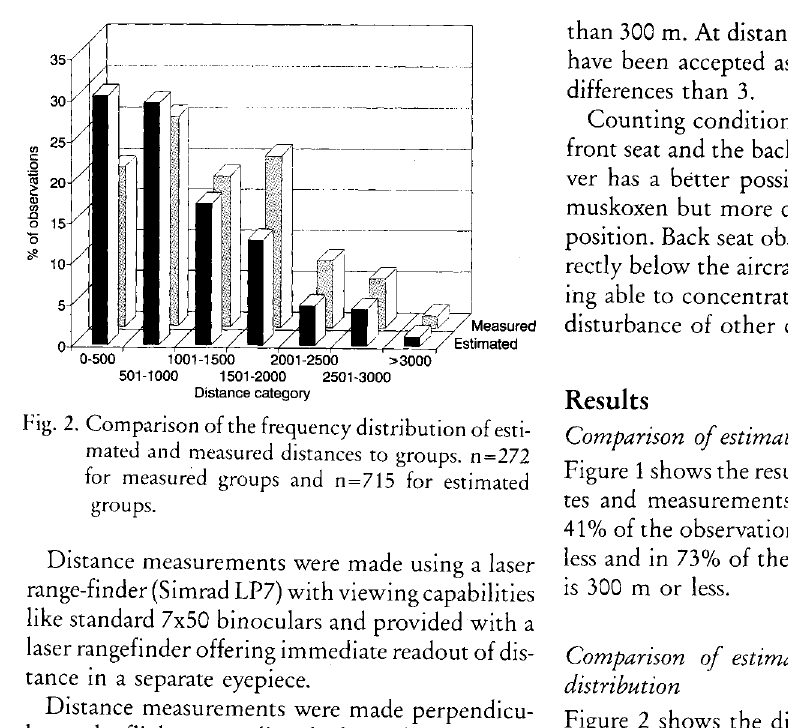
Fig. 2. Comparison of the frequency distribution of esti mated and measured distances to groups. n=272 for measured groups and n=715 for estimated groups.